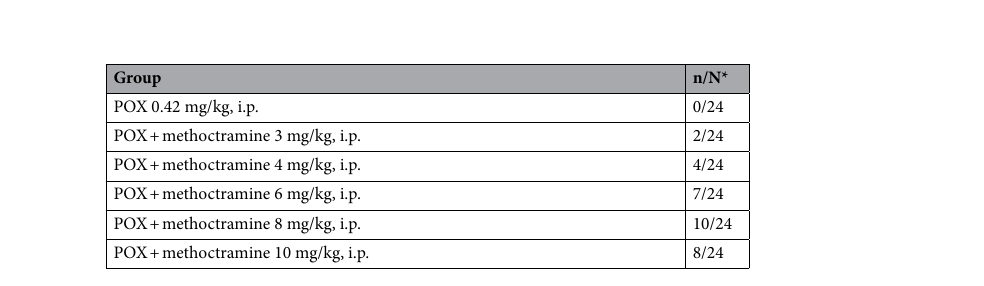
Group n/N* POX 0.42 mg/kg, i.p. 0/24 POX + Atropine 6 mg/kg, i.p. 0/24 POX + Atropine 8 mg/kg, i.p. 2/24 POX + Atropine 10 mg/kg, i.p. POX + Atropine 15 mg/kg, i.p. POX + Atropine 20 mg/kg, i.p. Table 1. Selection of atropine dose for antidotal therapy of mice poisoned by 2xLD 50 of POX. * n number of mice survival 120 h after POX poisoning. N total number of mice in the group. POX—0.42 mg/kg, i.p.